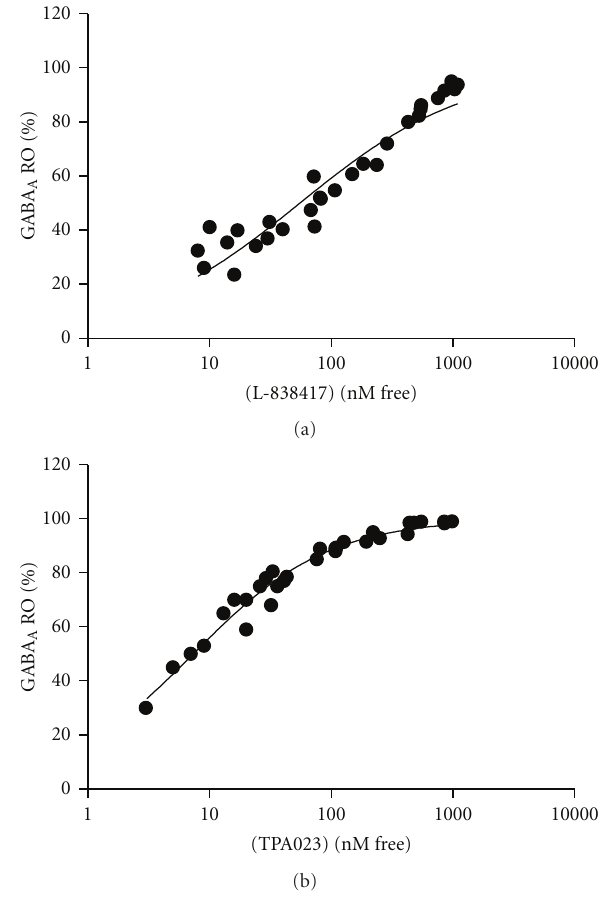
Figure 1: GABA A receptor occupancy of (a) L-838,417 and (b) TPA023 in whole rat brain compared to drug concentrations in the plasma (nM free). Each datapoint represents an individual